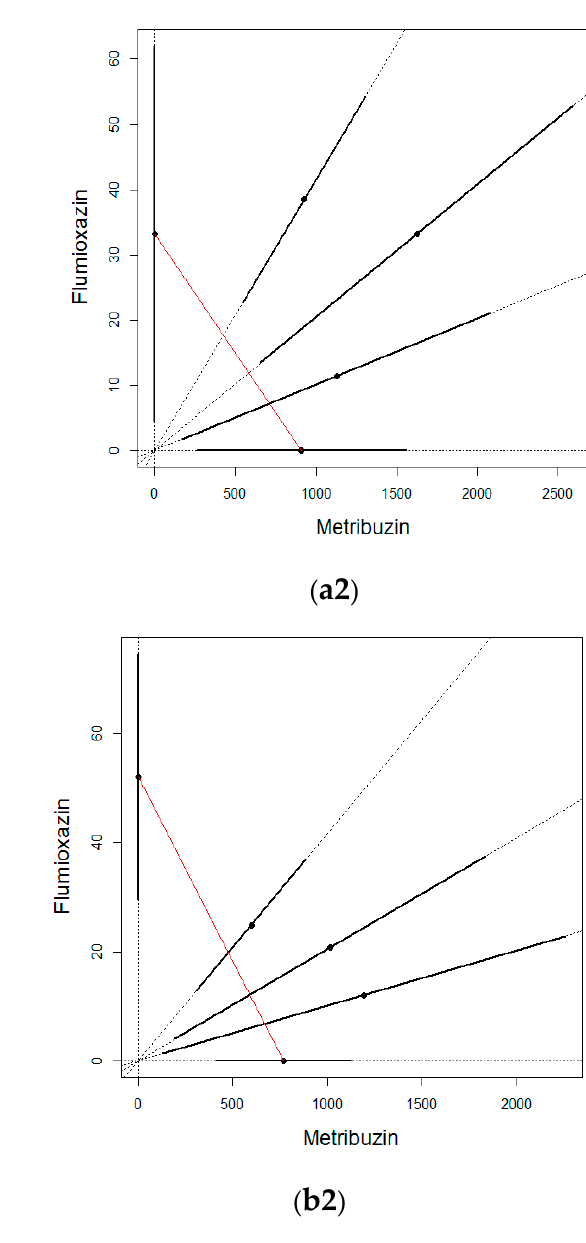
Figure 3. ED 50 isobologram show the interactions of metribuzin:halosulfuron ( a ) and metribuzin:flumioxazin ( b ) on potato fresh weight in first experiment ( 1 ) and second experiment ( 2 ). The straight line of isobologram indicates additivity. The lines around the mixture points are 95% confidence intervals.